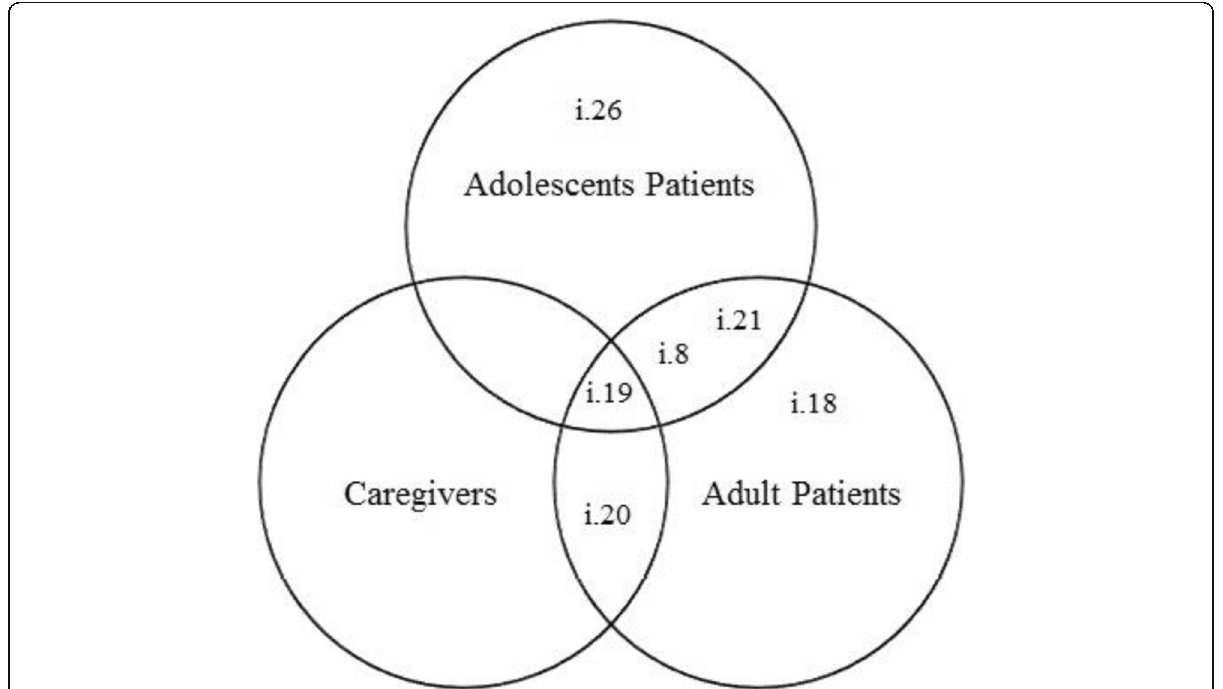
Fig. 1 Similarities and particularities between groups according to Phenylketonuria Perceived Barrier to Treatment Inventory items mentioned by more than 50% of the